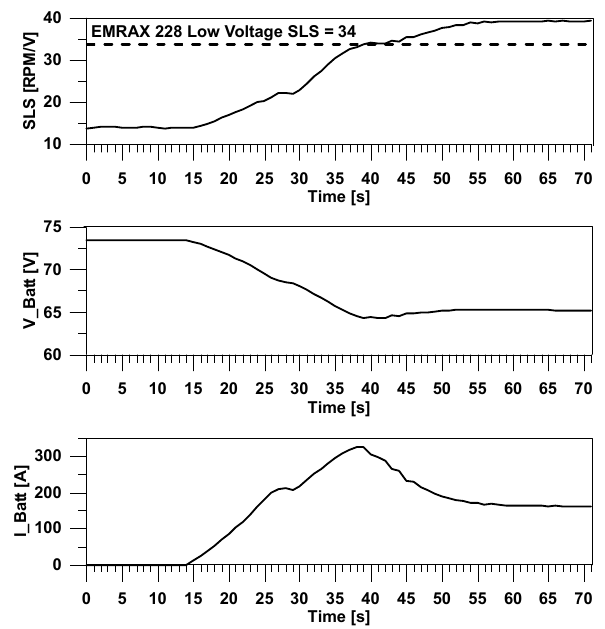
Figure 10. Test 2: calculated SLS, battery voltage and current.